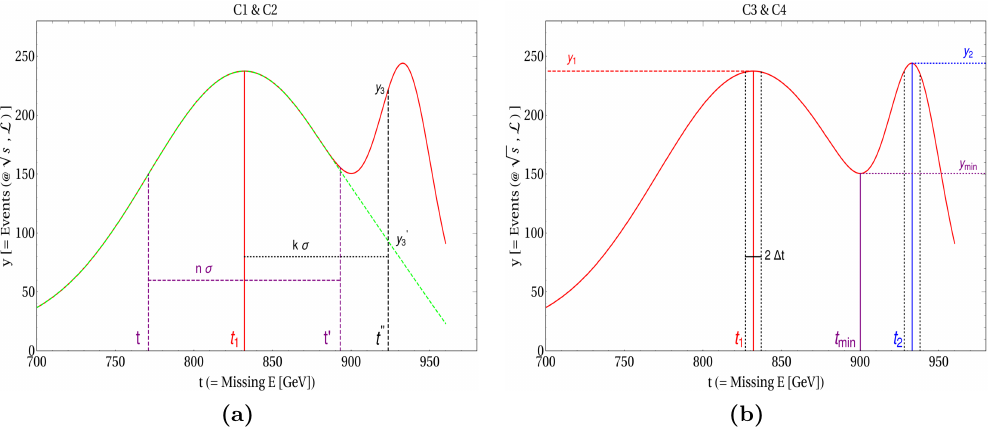
( ≡ y ) vs /E ( ≡ t) plane with d/E